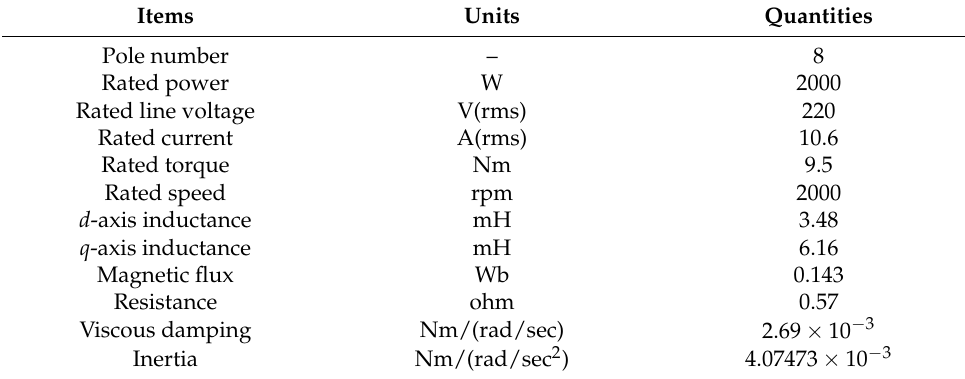
Table 2. Parameters of IPMSM.